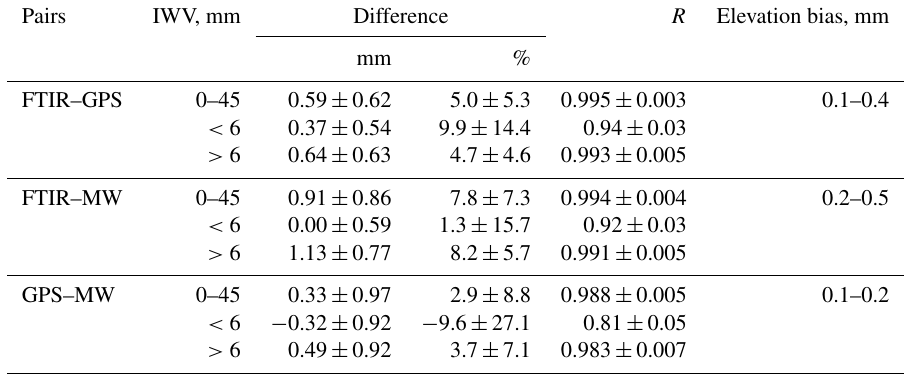
Table 5. Statistics of differences (mean ± SD) for all coincident IWV pairs depending on IWV values. Relative values correspond to the first instrument in pairs. R is the correlation coefficient. The elevation bias is an estimated difference due to the difference in elevation of the instruments. The number of measurements total 819, 161, and 658 for 0–45, 0–6, and 6–45mm data sets,